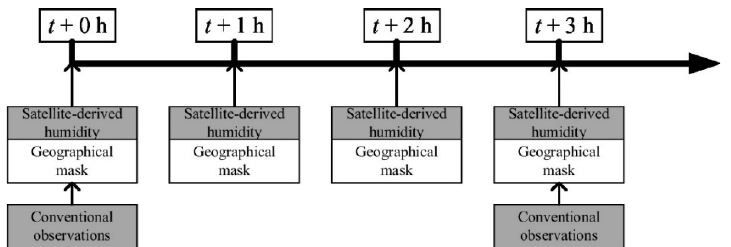
Figure 5. Schematic of data assimilation experiment configuration. The conventional (satellite-derived humidity) data assimilation adopts the 3 h (hourly) cycling. The 6 h free forecast is initialized every hour from t + 0 h to t + 3 h. For satellite-derived humidity assimilation, the geographical mask is defined by the observed 3D sea fog distributions valid at the cycle time.